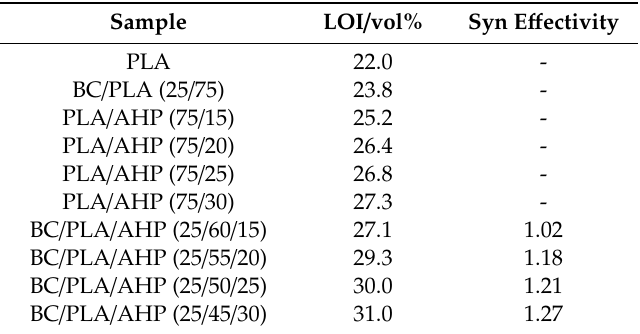
Figure 7. Appearance of test materials before and after cone calorimeter test.